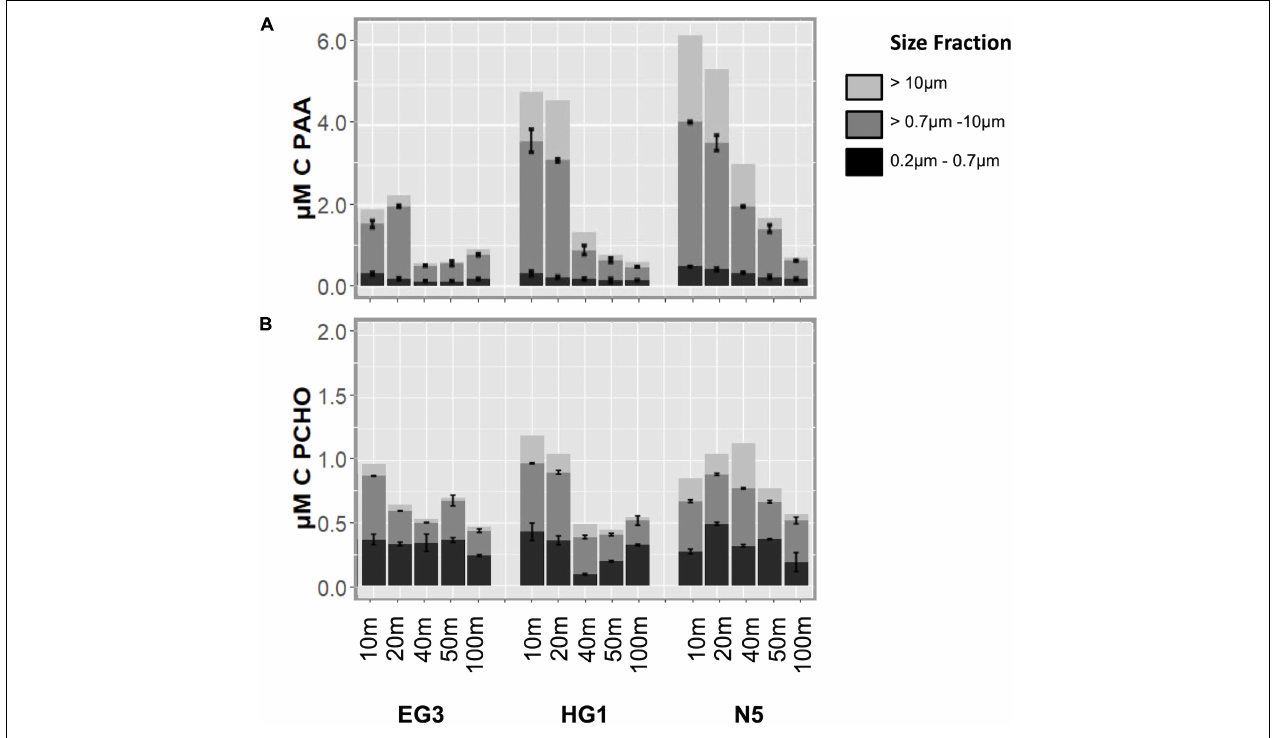
FIGURE 6 | Contribution of different size fractions to concentrations of PAA (A) and PCHO (B) . Note differences in scales between panels.